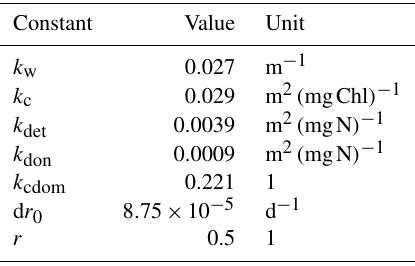
Table 1. Constants of the optical model.